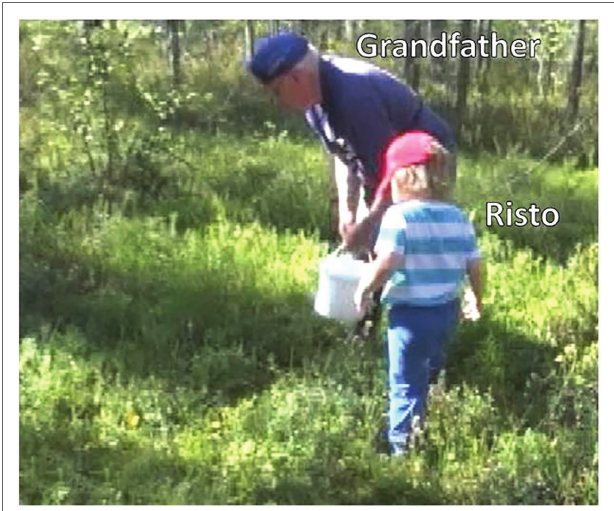
FIGURE 8 | Grandfather turns away and Risto orients toward the picking spot.